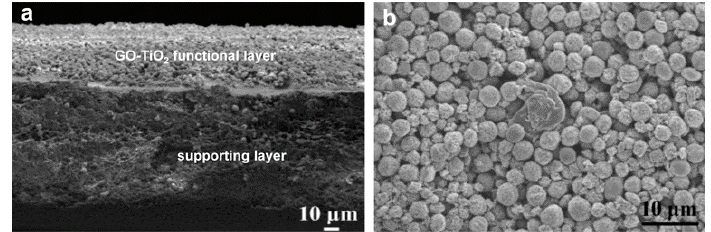
Figure 8. Scanning electron microscopy (SEM) images of GO-TiO 2 membrane (( a ) cross view; ( b ) top view). Figures are reprinted with permission from Ref. [99]. Elsevier, 2013.